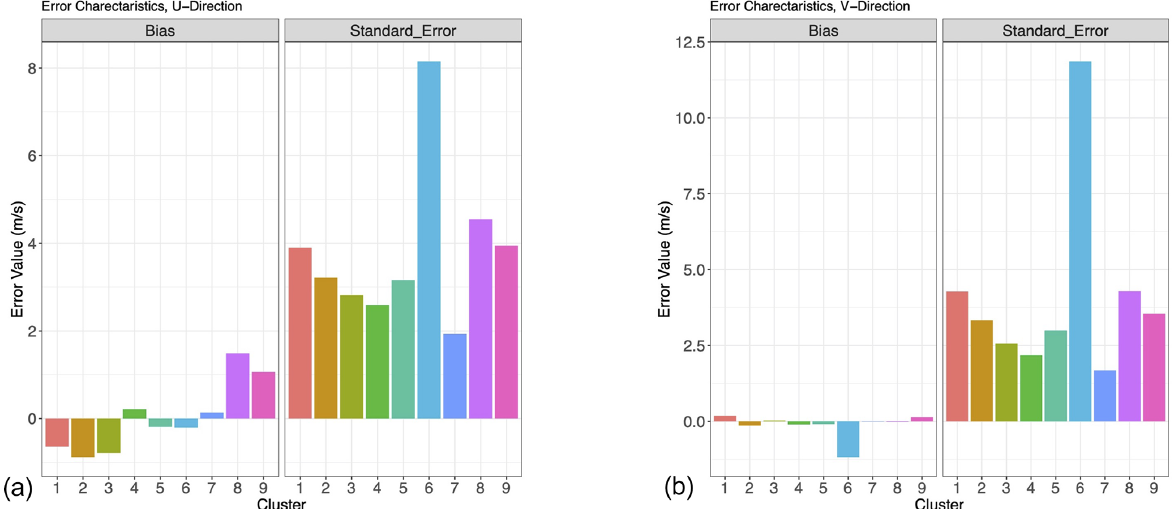
Figure 15. (a) Bias (left panel) and standard error (right panel) for each Gaussian mixture cluster in Fig. 6, u direction. (b) Same as panel (a) for v